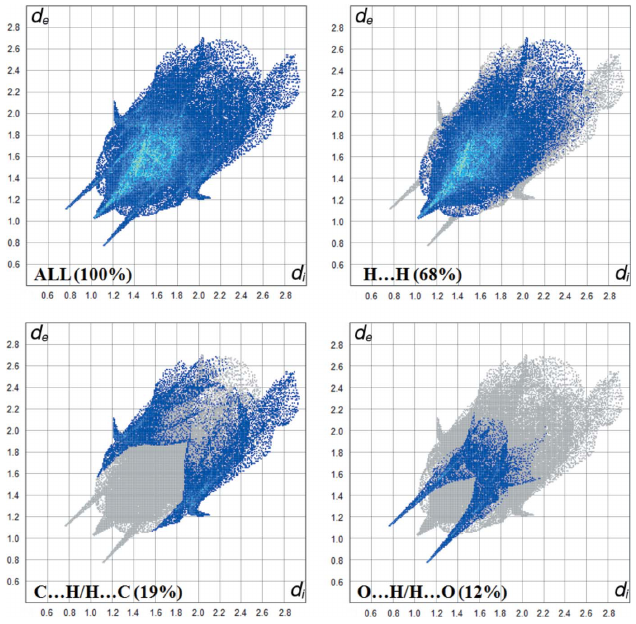
Figure 4 The view of the two-dimensional fingerprint plots for the title